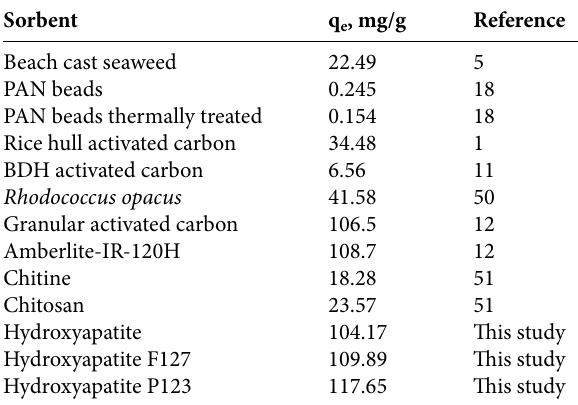
Table 5. Comparative result of adsorption efficiency of different type of sorbents towards Al(III).